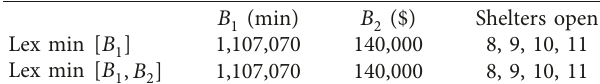
Table 8: Lexicographic